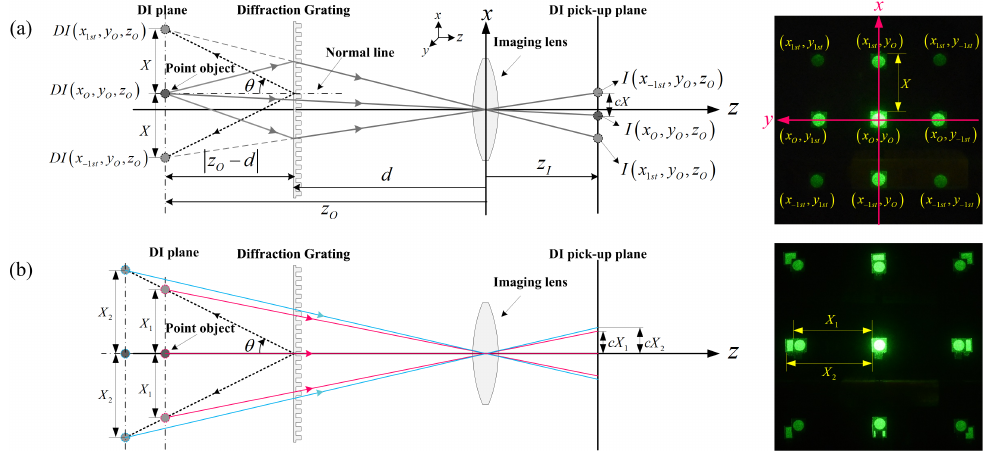
Figure 1. Geometric relations in diffraction grating imaging and examples of diffraction image array (DIA). ( a ) On the left, geometric relationship for point object, diffraction images (DIs), diffraction grating and imaging lens. On the right, it is an example of the DIA; ( b ) On the left, the spatial period of the diffraction image array according to the depth of the object. On the right, it is the example of the